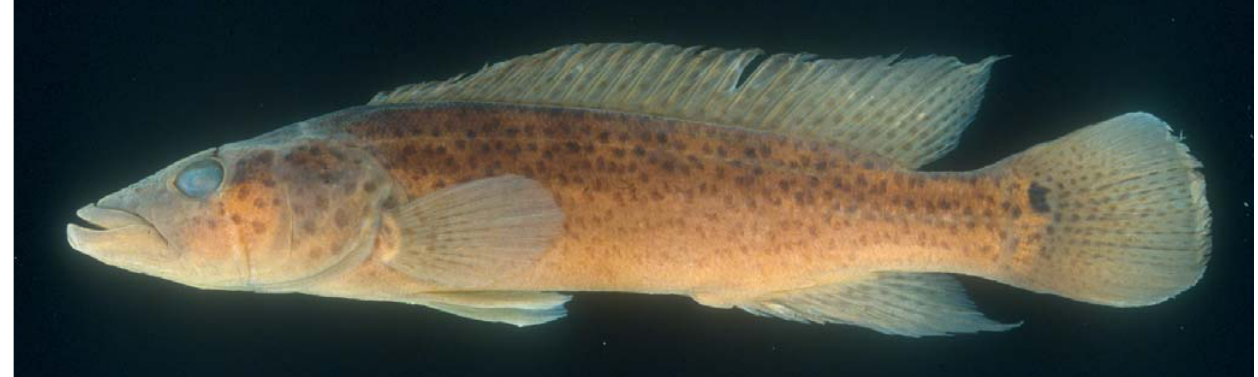
Fig. 3. Crenicichla lacustris , male, MNRJ 14394, 173.7 mm SL, ribeirão São Domingos, rio Muriaé drainage, State of Rio de Janeiro, Brazil.